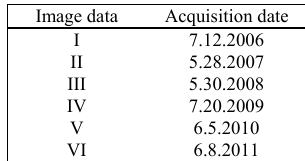
Table 2. Acquisition time of the six Landsat TM images used in